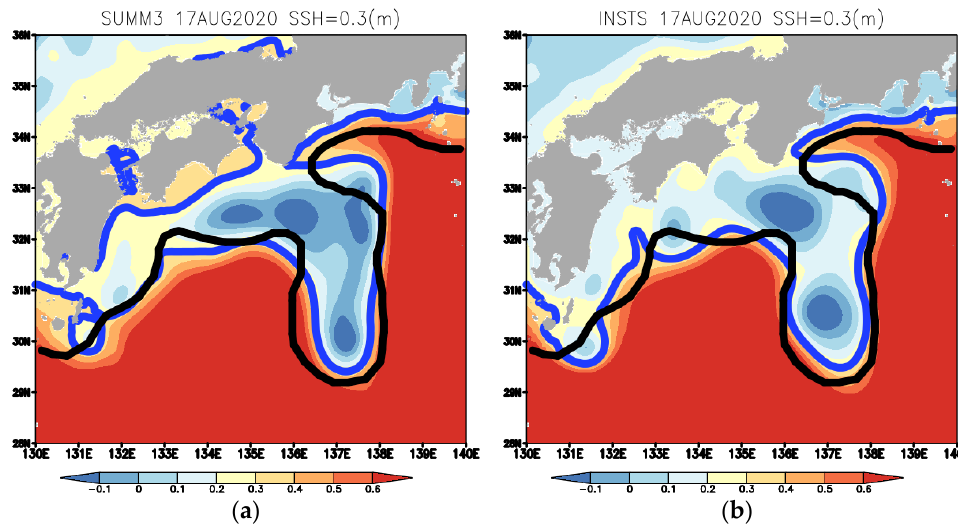
Figure 12. Same as Figure 6 except for ( a ) the SUMM3 case and ( b ) the INSTS case.